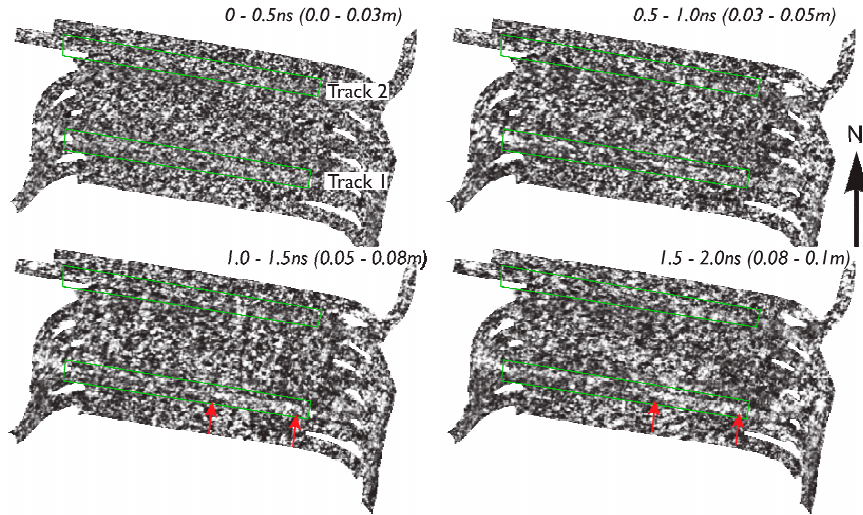
Figure 9. Field GPR data collected immediately after the equine locomotion analysis. The red arrows indicate enhanced wear from the right of Track 1 where the archaeology provides more firm ground conditions, encouraging the horses to transfer more energy during forward propulsion.